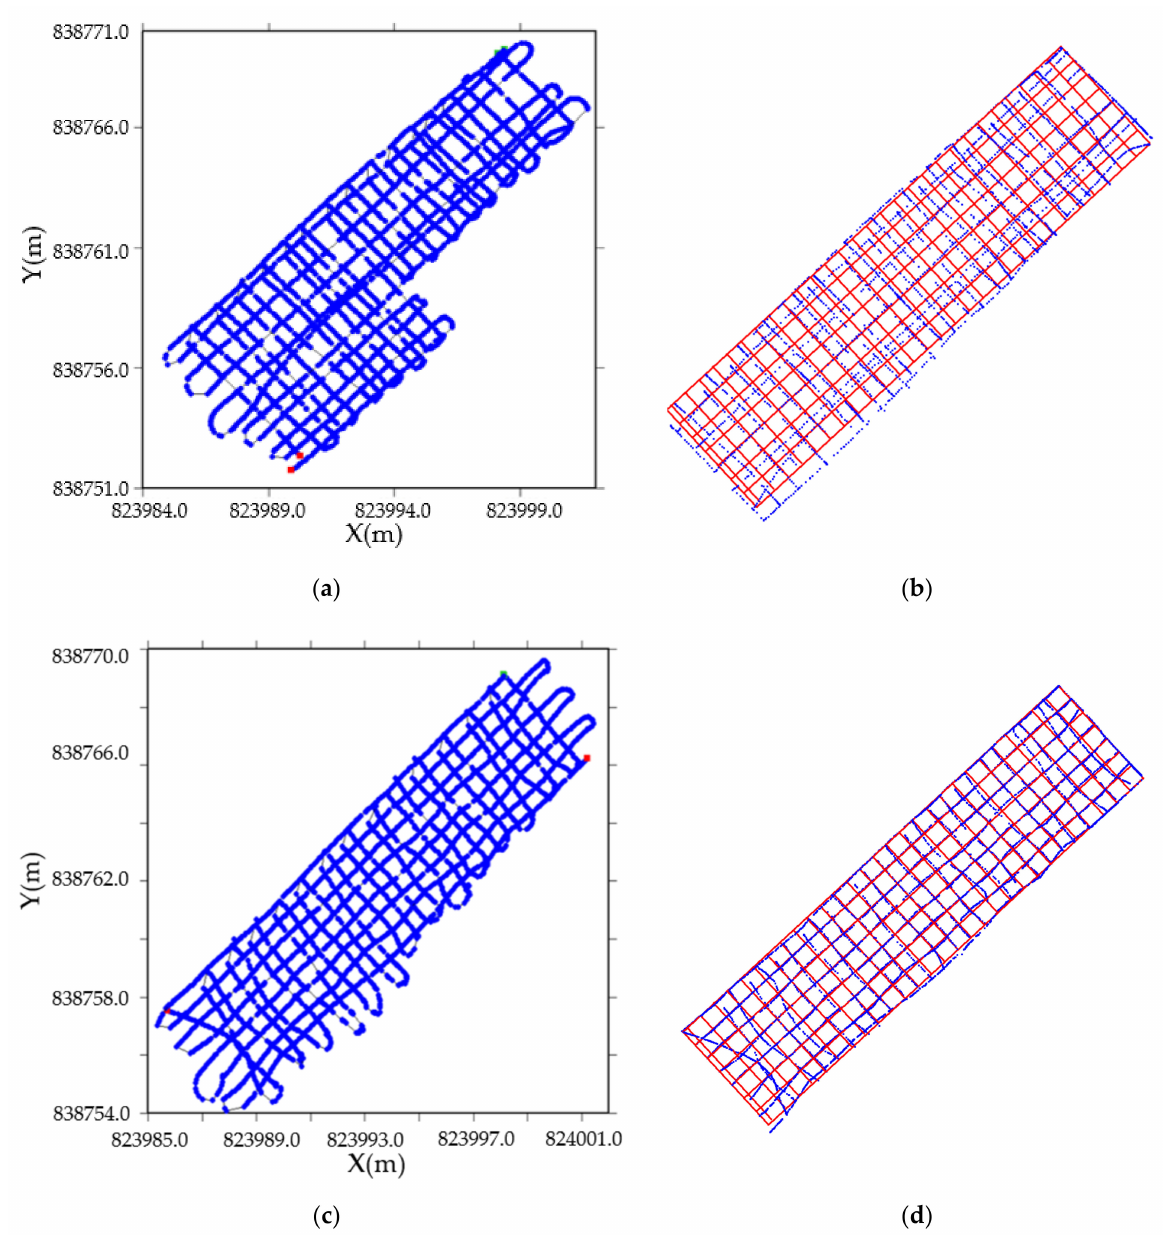
Figure 11. ( a , c ) The survey paths of methods T2 and T3, respectively; ( b , d ) the comparisons of such paths with the designed path